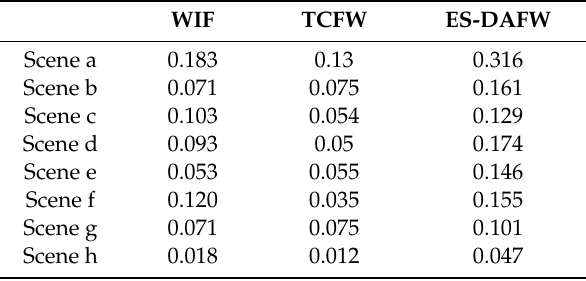
Table 7. The average slopes of the three window selection methods around the focus position in different scenes.